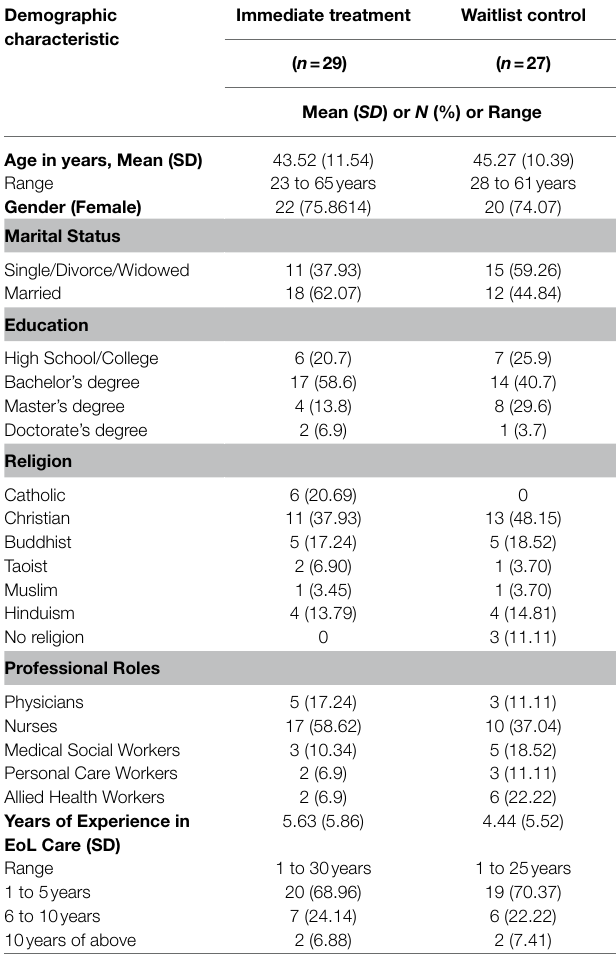
TABLE 2 | Participant demographic